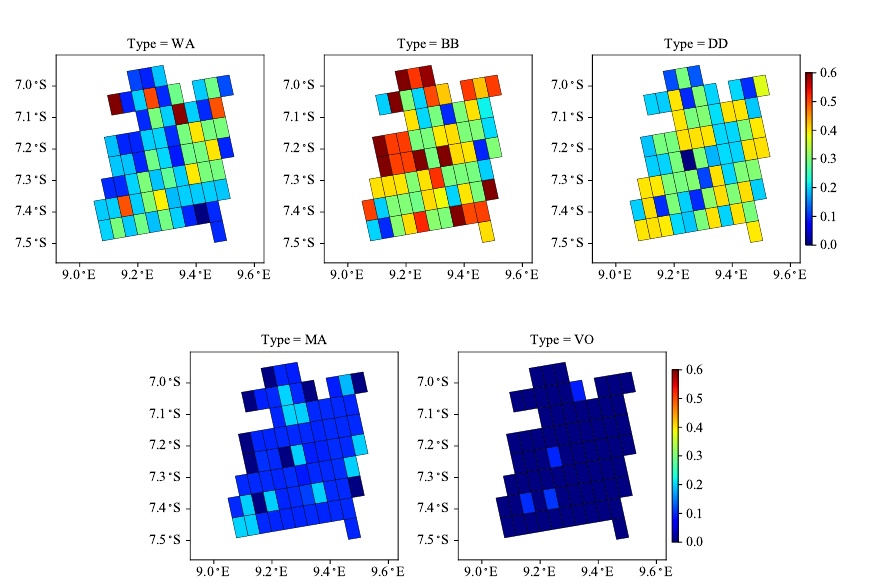
Figure 14. The same as in Figure 11 but for the data on 5 July 2019.